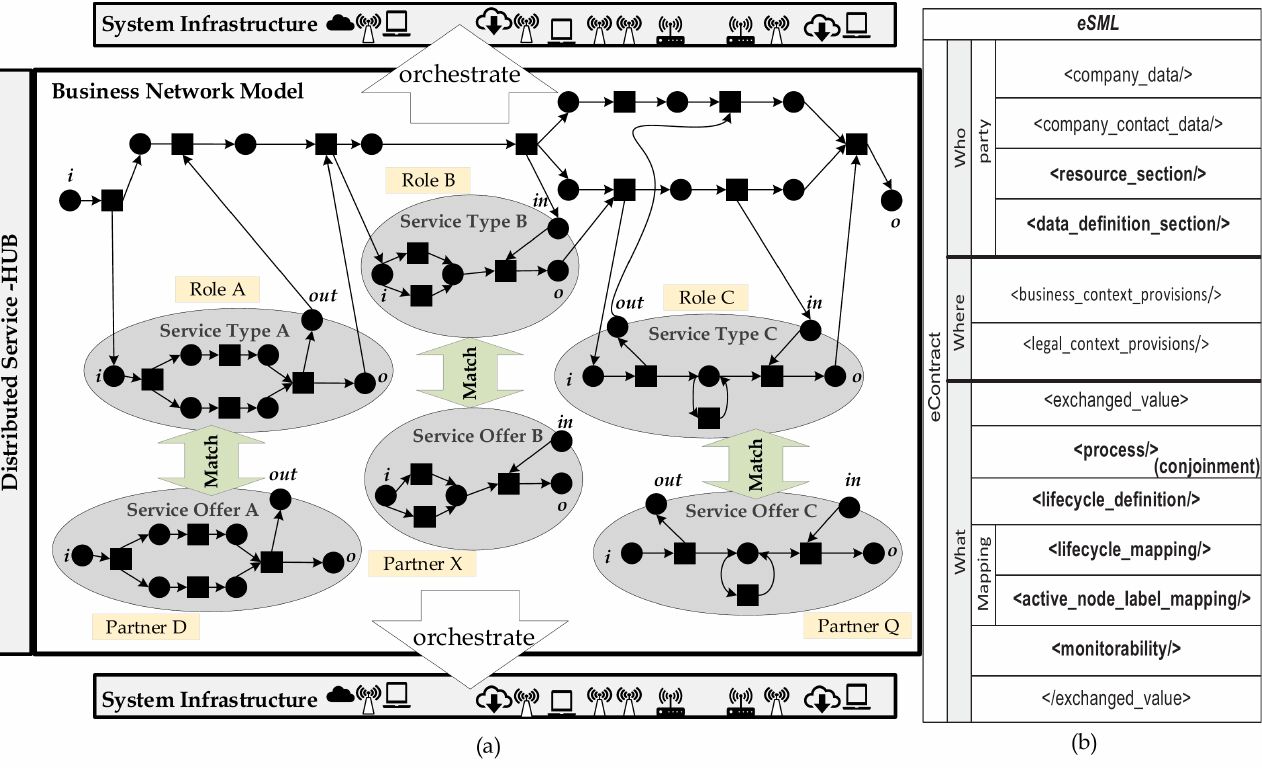
Figure 4. ( a ) P2P service matching and provision of the M2X ecosystem using the eSourcing framework–(Based on) [23]. ( b ) The eSourcing Markup Language (eSML) for specifying contractual collaborations–Based on